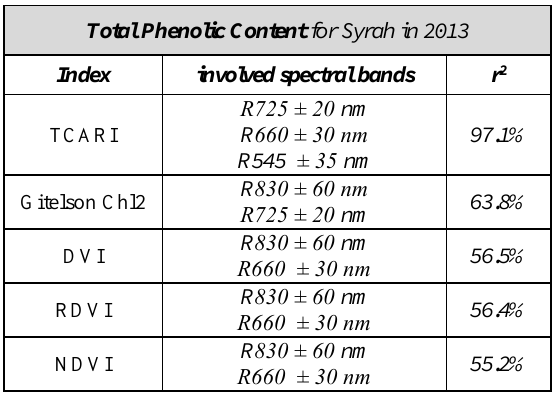
3. Along with the NIR1 (R850 ± 10 0 nm), Red and Blue spectral bands also delivered high correlation rates 4. Vegetation indices DVI/RDVI and MCARI1 also delivered high correlation values between 74% and 78%